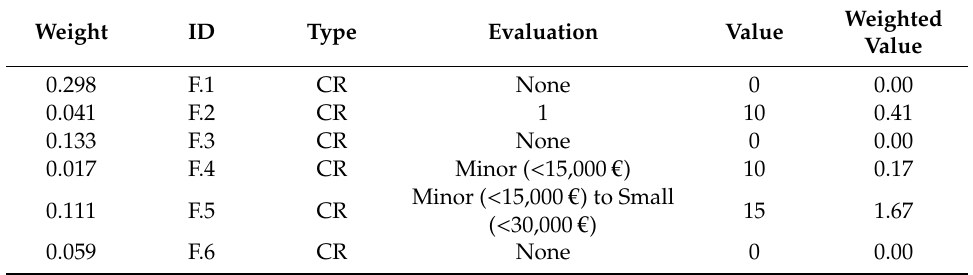
Table A19. Evaluation table of destruction and damages to infrastructure from the Evros fire. CR: criterion. Original matching Table